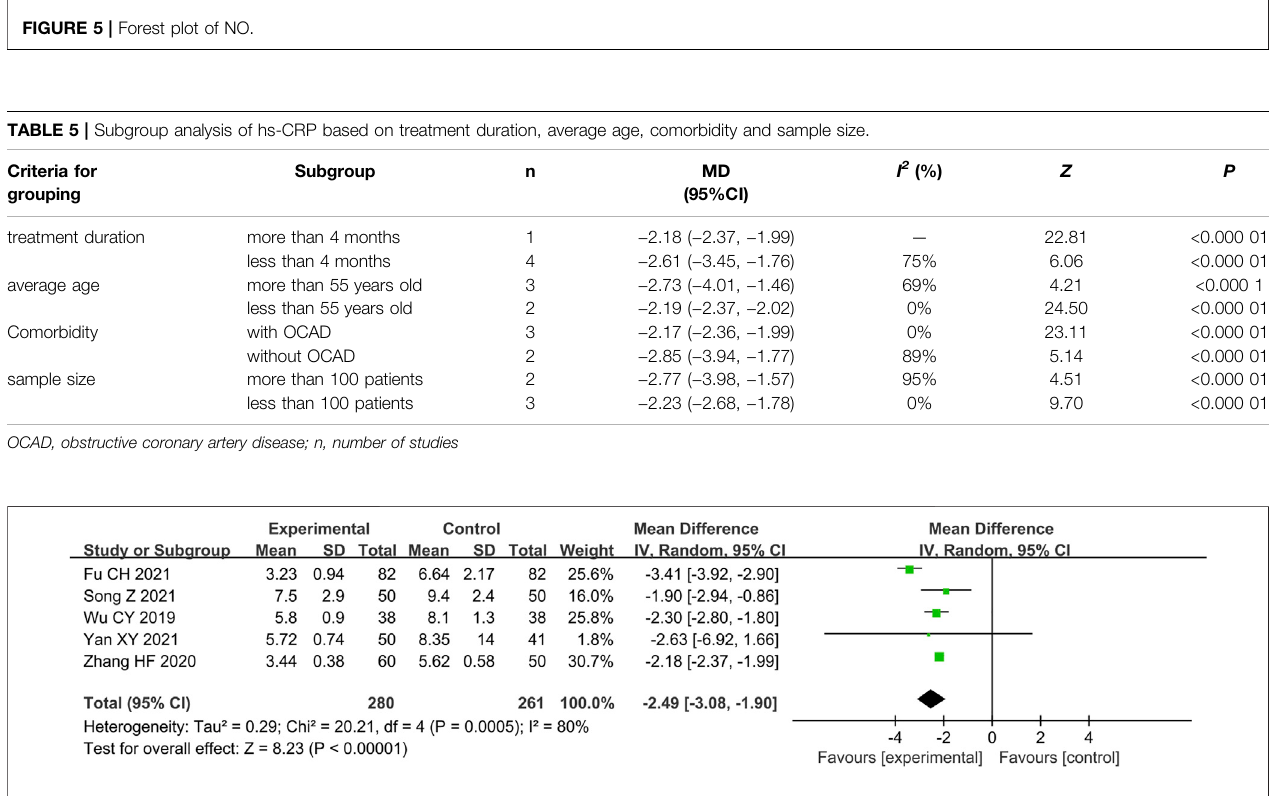
FIGURE 6 | Forest plot of